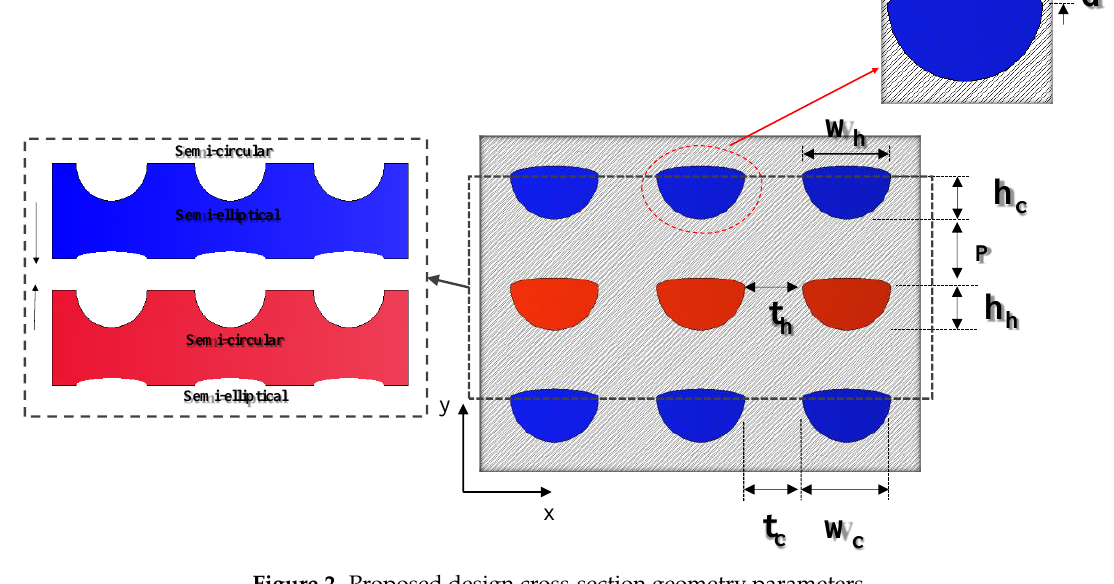
Figure 2. Proposed design cross-section geometry parameters. Table 2. Geometric parameter of this study.